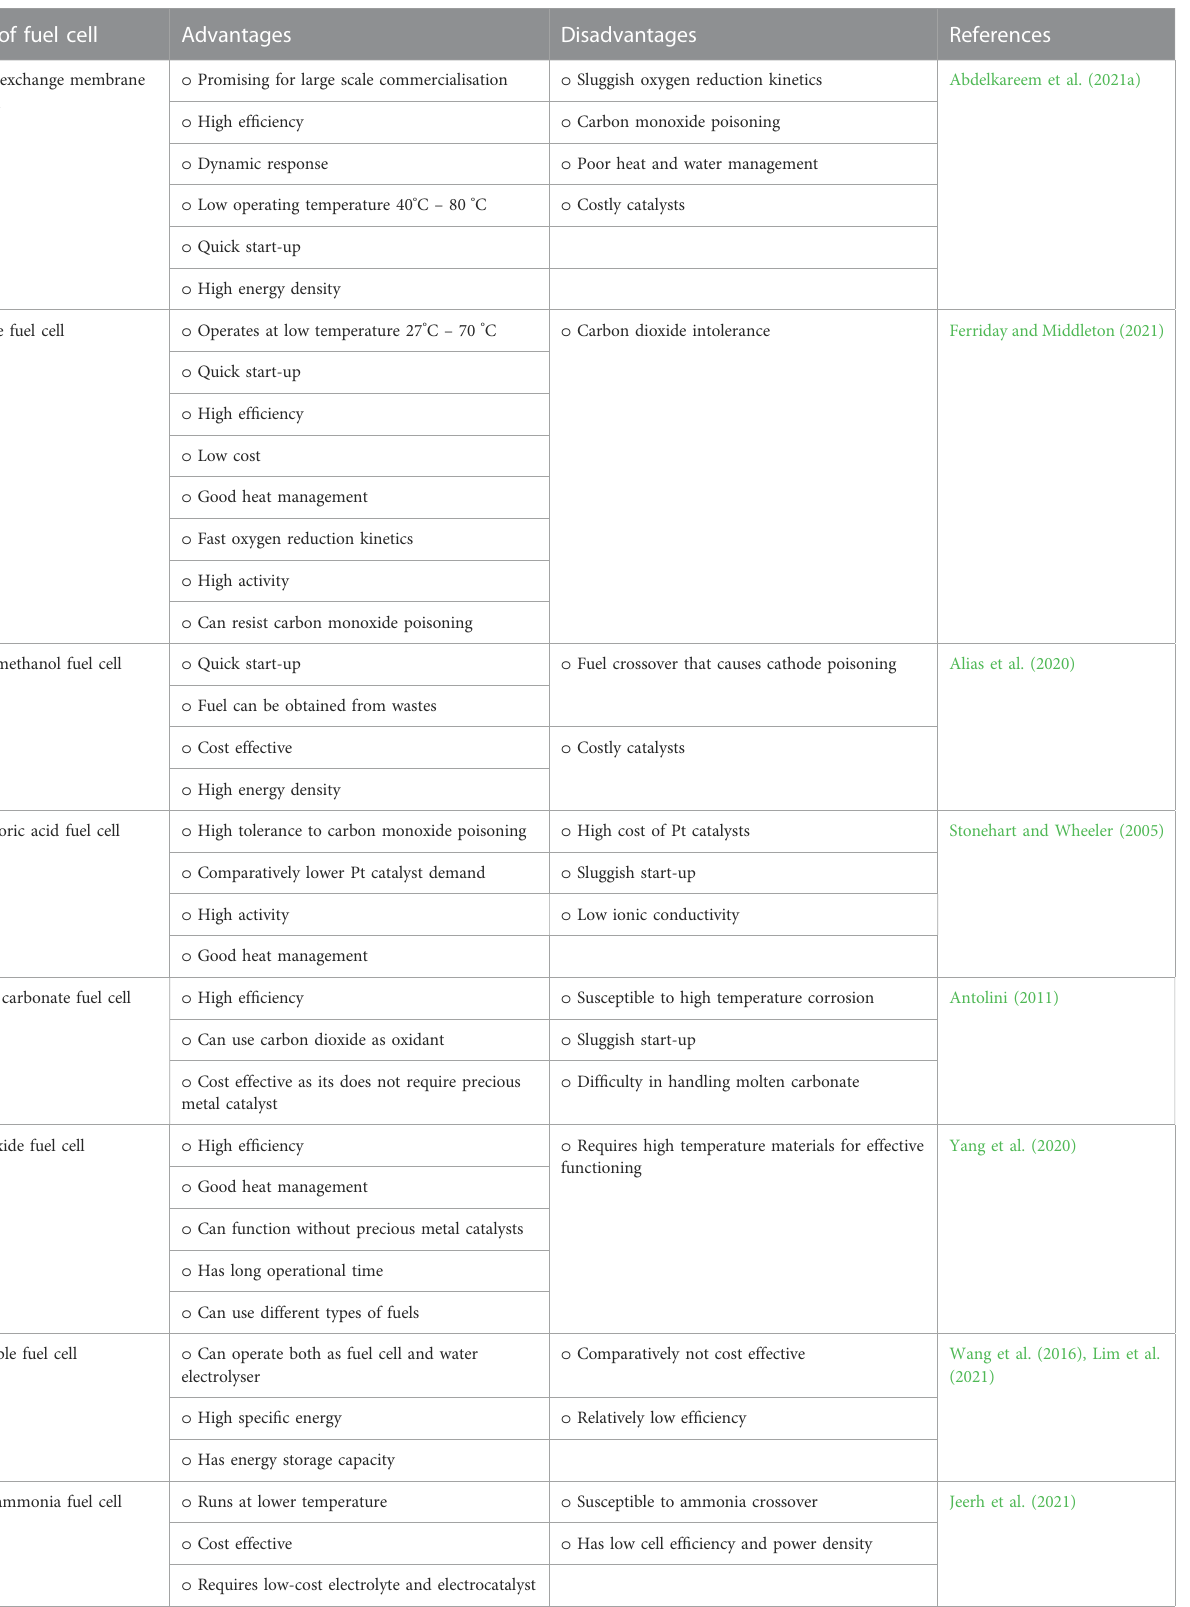
TABLE 1 Types of fuel